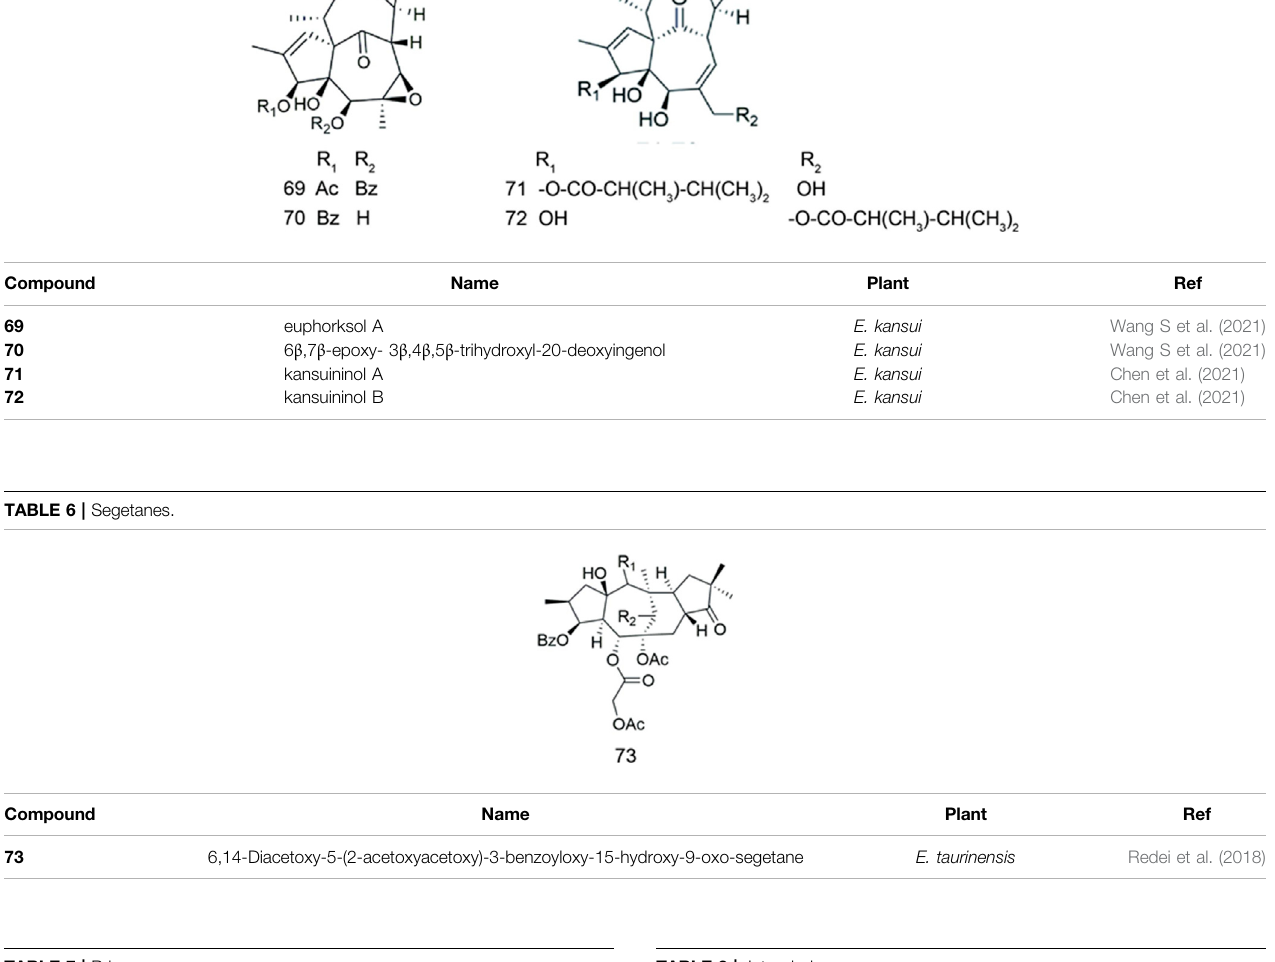
TABLE 7 | Briaranes. TABLE 8 |